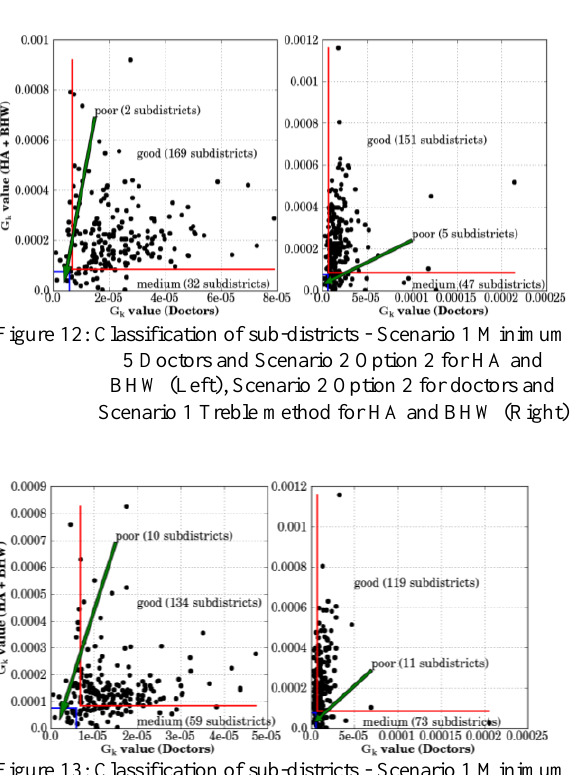
Figure 13: Classification of sub-districts - Scenario 1 Minimum 3 doctors and Scenario 2 Option 1 for HA and BHW (Left), Scenario 2 Option 1 for doctors and Scenario 1 Double method for HA and BHW (Right) The number of sub-districts in the good, medium and